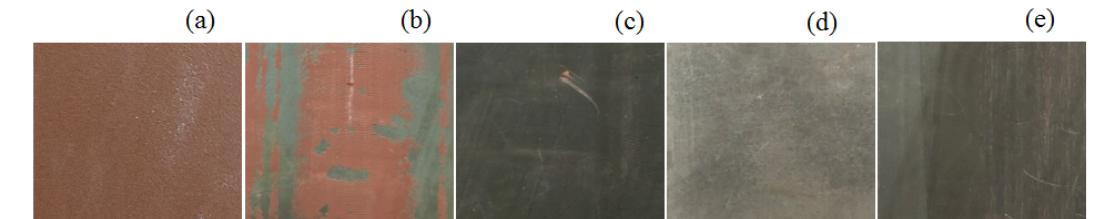
Figure 8. Surface condition under various water pressure levels ( a ) initial state; ( b ) 100 MPa; ( c ) 120 MPa; ( d )140 MPa; ( e )160 MPa.